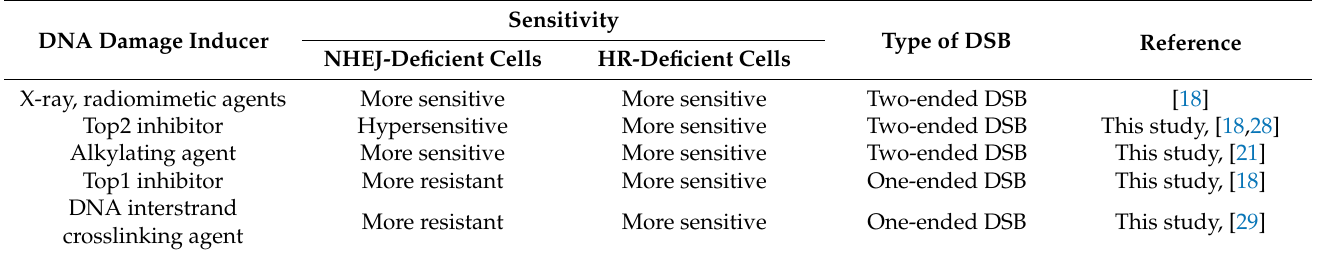
Table 1. Summary of the DSB types caused by DNA damage inducers analyzed using Nalm-6 cells. DNA Damage